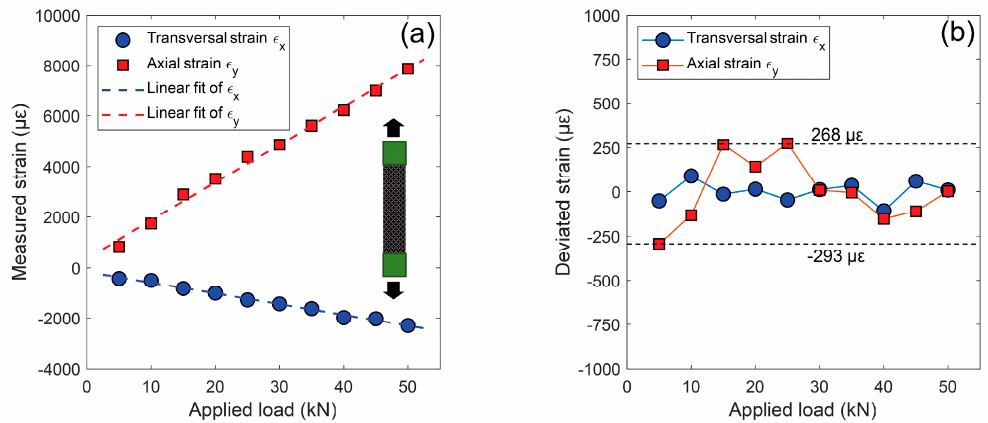
Figure 12. ( a ) Measured transversal ( ε x ) and longitudinal ( ε y ) strains (unit: με ) as a function of the applied loads and ( b ) deviated strains between the measured strains and fitted strains. Table 2. The elastic modulus and Poisson’s ratio measured by the smartphone-based stereo-DIC system. Test No.